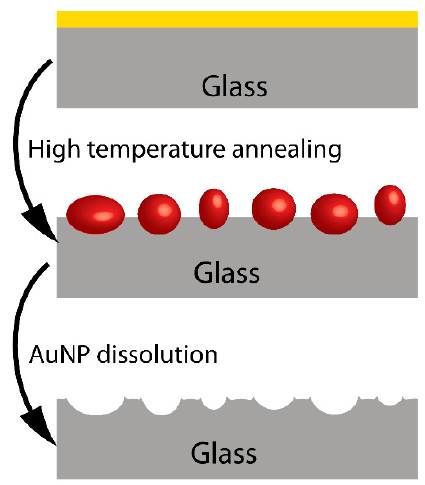
Figure 3. Schematic showing the traces of nano-islands in glass, after their removal by dissolution. After dissolving the gold, the authors could clearly see the traces of the nano-islands in the AFM (Atomic Force Microscopy) and SEM images. If the nano-islands are not stabilized, immersion in the